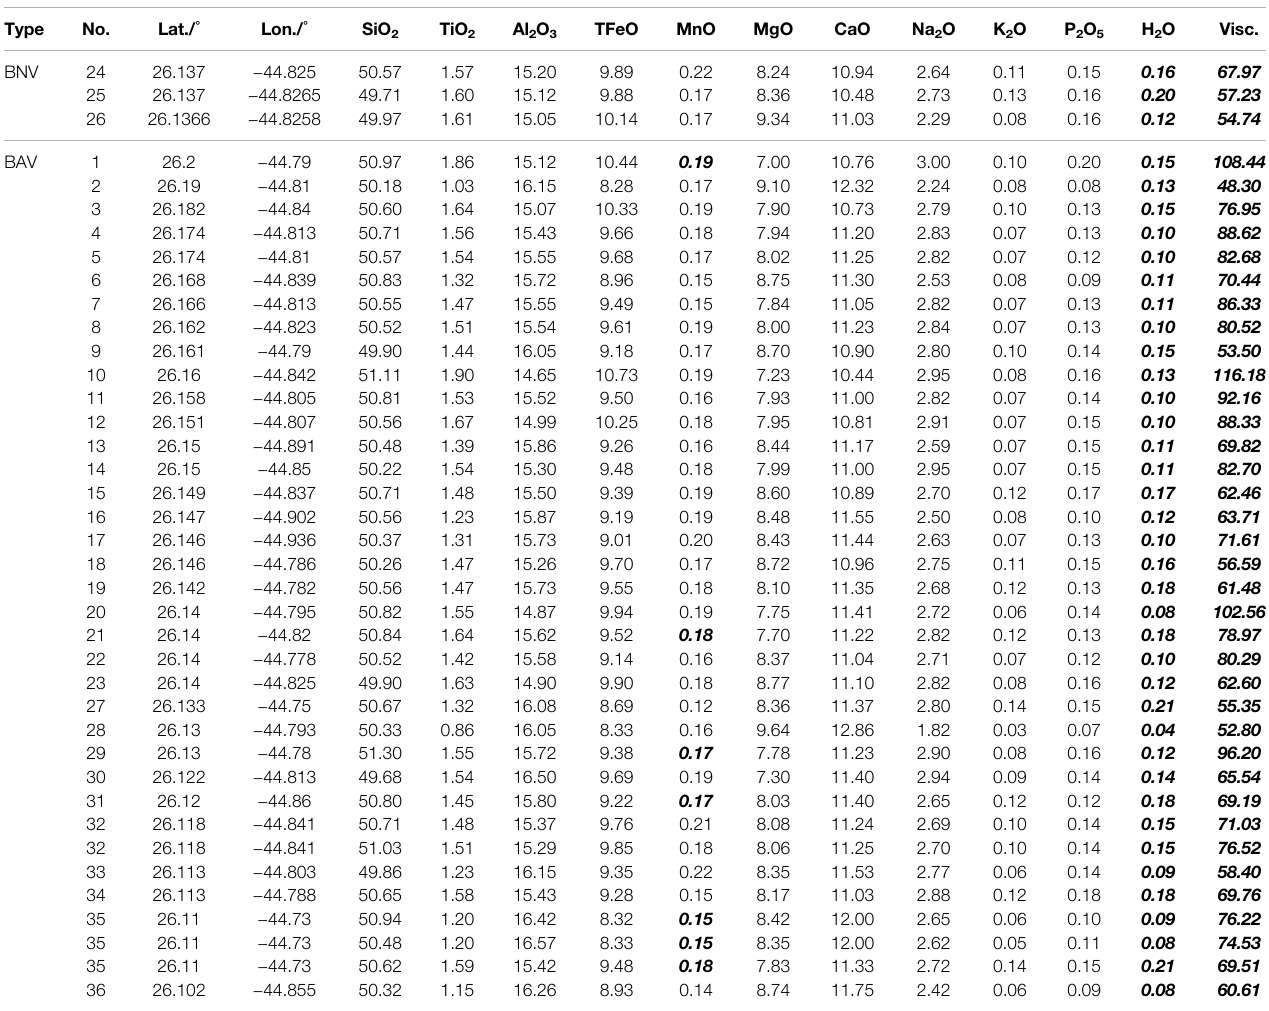
TABLE 4 | Major elements (wt%) and viscosity of basalt (Pa · s) on TAG vent (data from